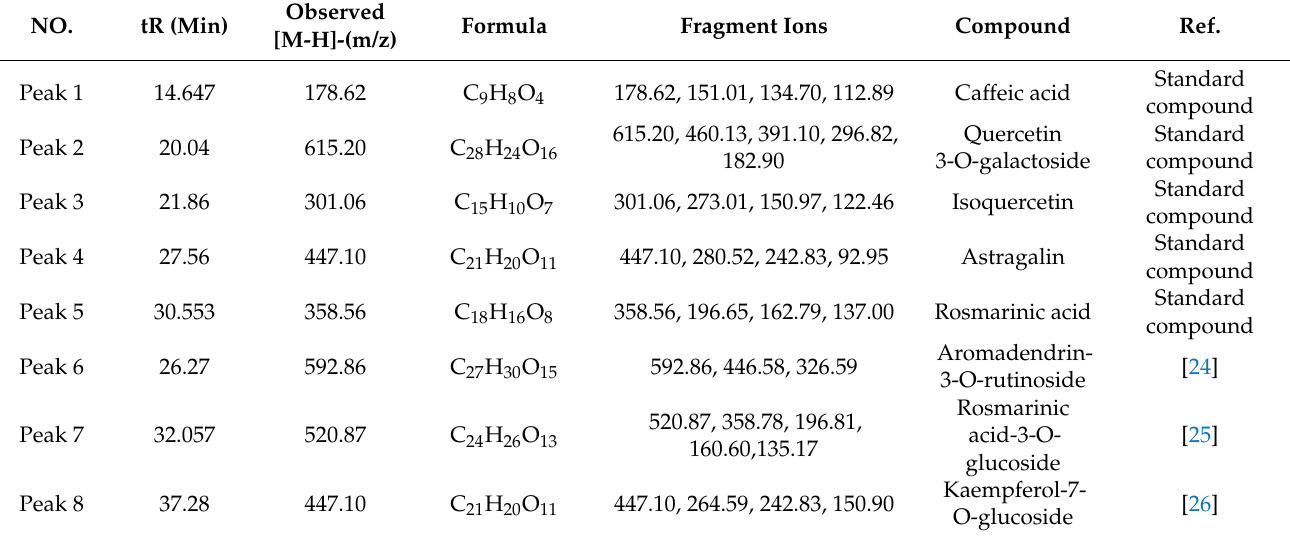
Table 2. HPLC-MS analysis of